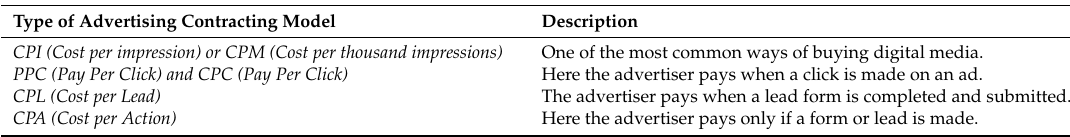
Table 5. Type of advertising contracting model.